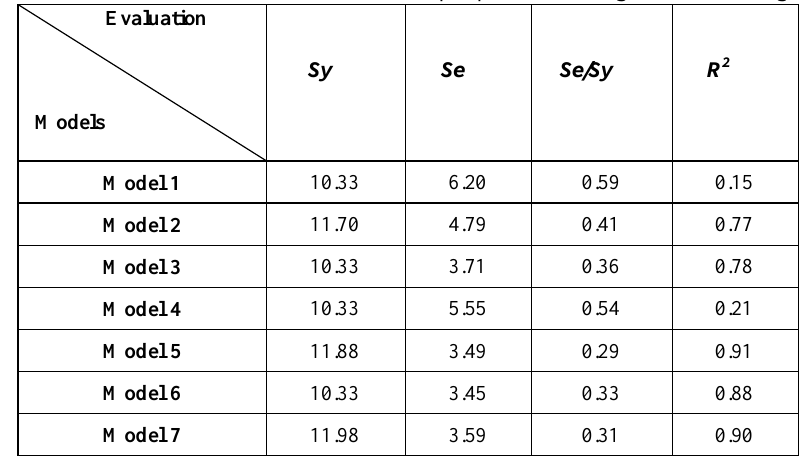
Table 2. Evaluation ANN with various input patterns during network testing